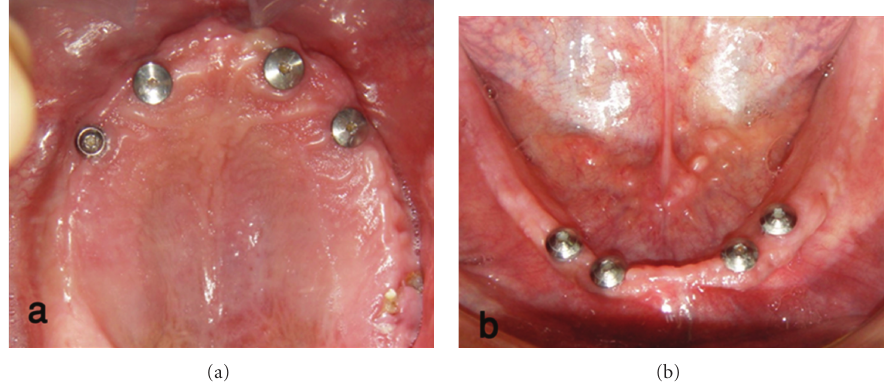
Figure 1: (a) Occlusal view after implant placement in maxilla. (b) Occlusal view after implant placement in mandible.